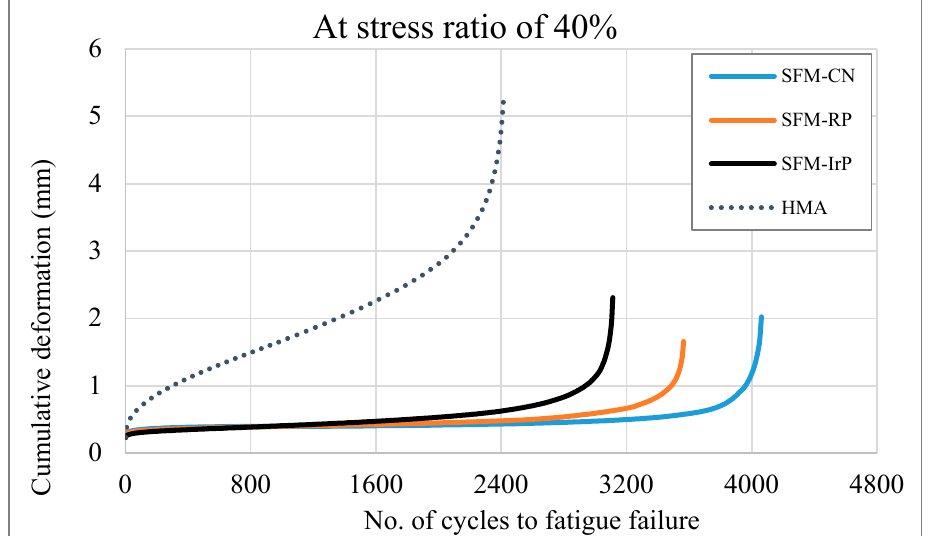
Figure 12. Number of fatigue cycles vs cumulative deformation at 40% stress ratio .